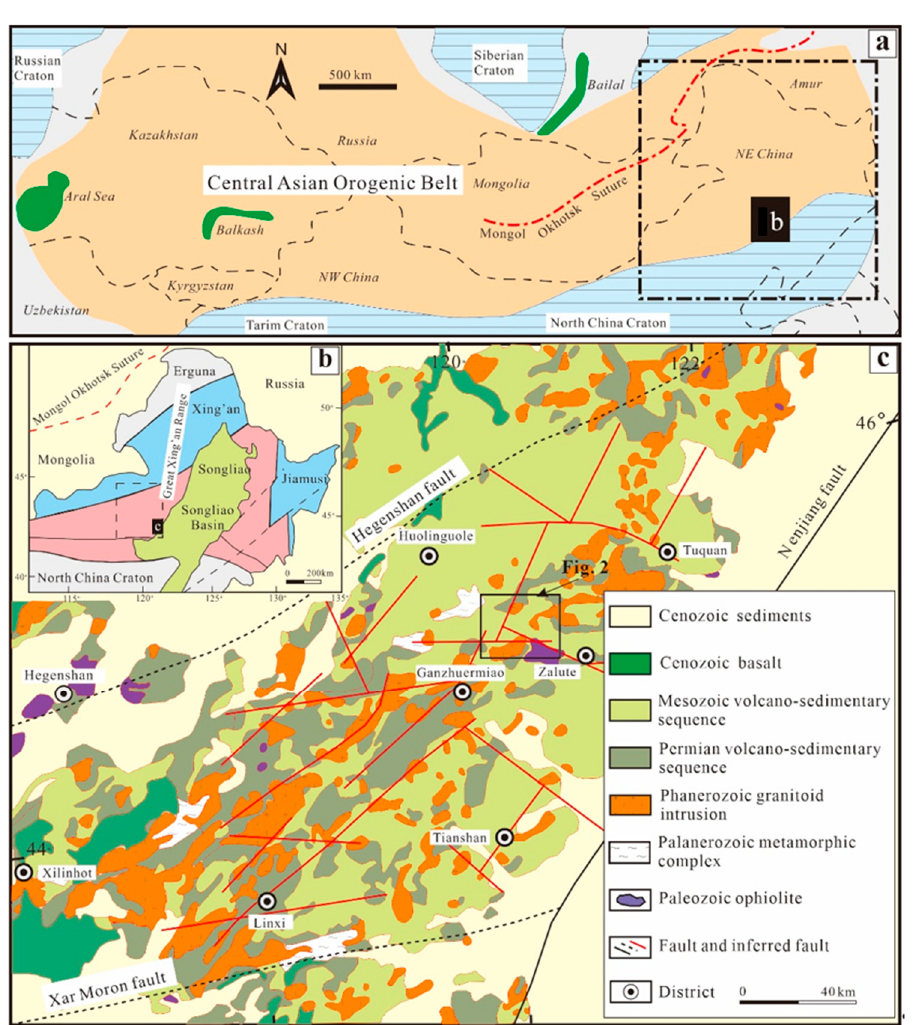
Figure 1. ( a ) Schematic map of the Central Asian Orogenic Belt (after Shen et al. [28]) showing the location of NE China; ( b ) Simplified geotectonic division of NE China (after Zhang et al. [37]), showing the location of the SGXR; and ( c ) Geologic sketch map of the southern Great Xing’an Range (SGXR) (modified after Ouyang et al. [14] and Guo et al. [41]).